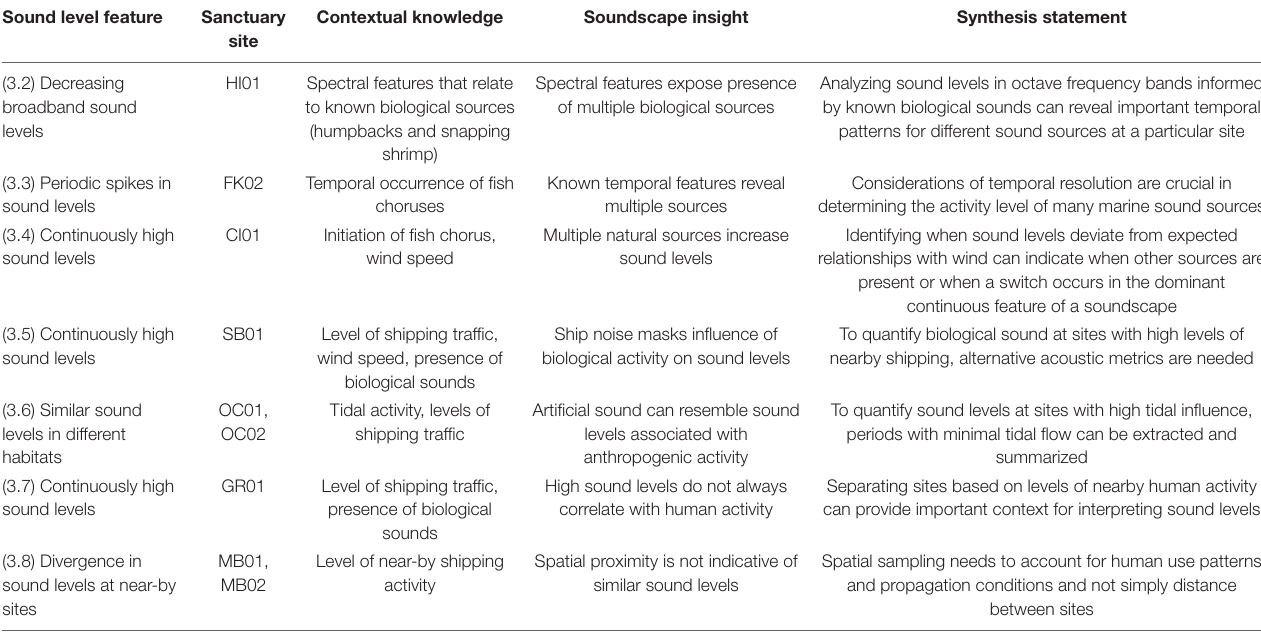
TABLE 2 | Summary of soundscape insights from combining sound level characteristics with source identification and site features (contextual knowledge).